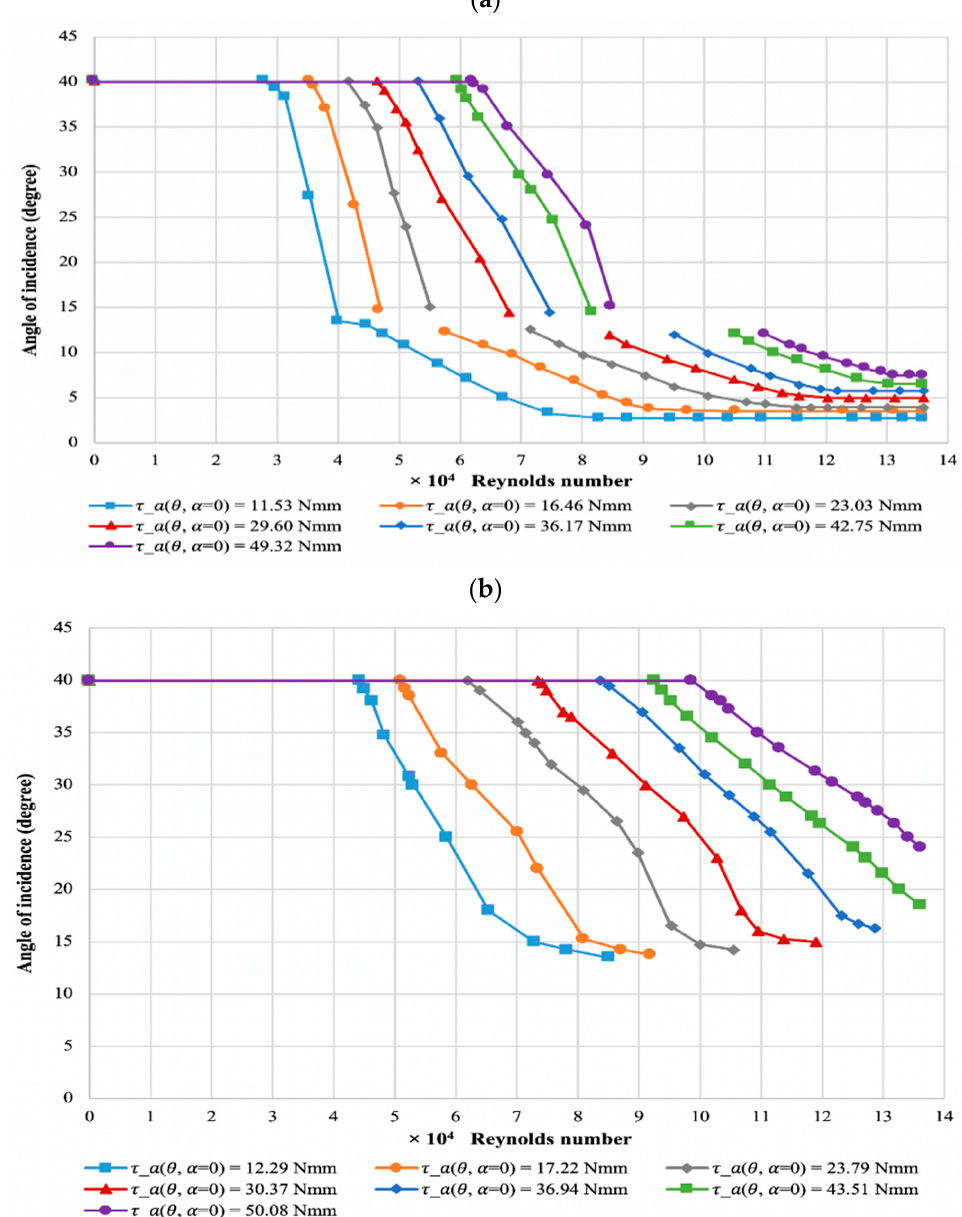
Figure 4. Response of the angle of incidence against flow velocity for ( a ) MP1 and ( b ) MP2 of NACA 0012.